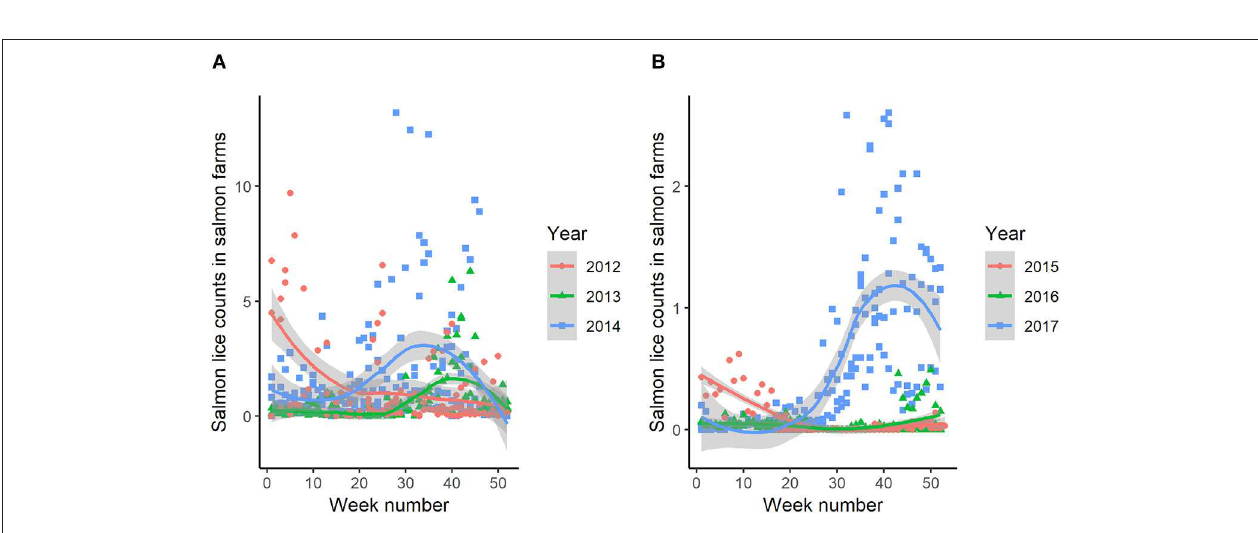
FIGURE 3 | Salmon lice prevalence (all life stages combined) reported by the salmon farms located within the study area in Hemnfjord (A) and Tosenfjord (B) . Colored lines indicate the smoothed conditional mean and its pointwise 95% confidence interval (shaded